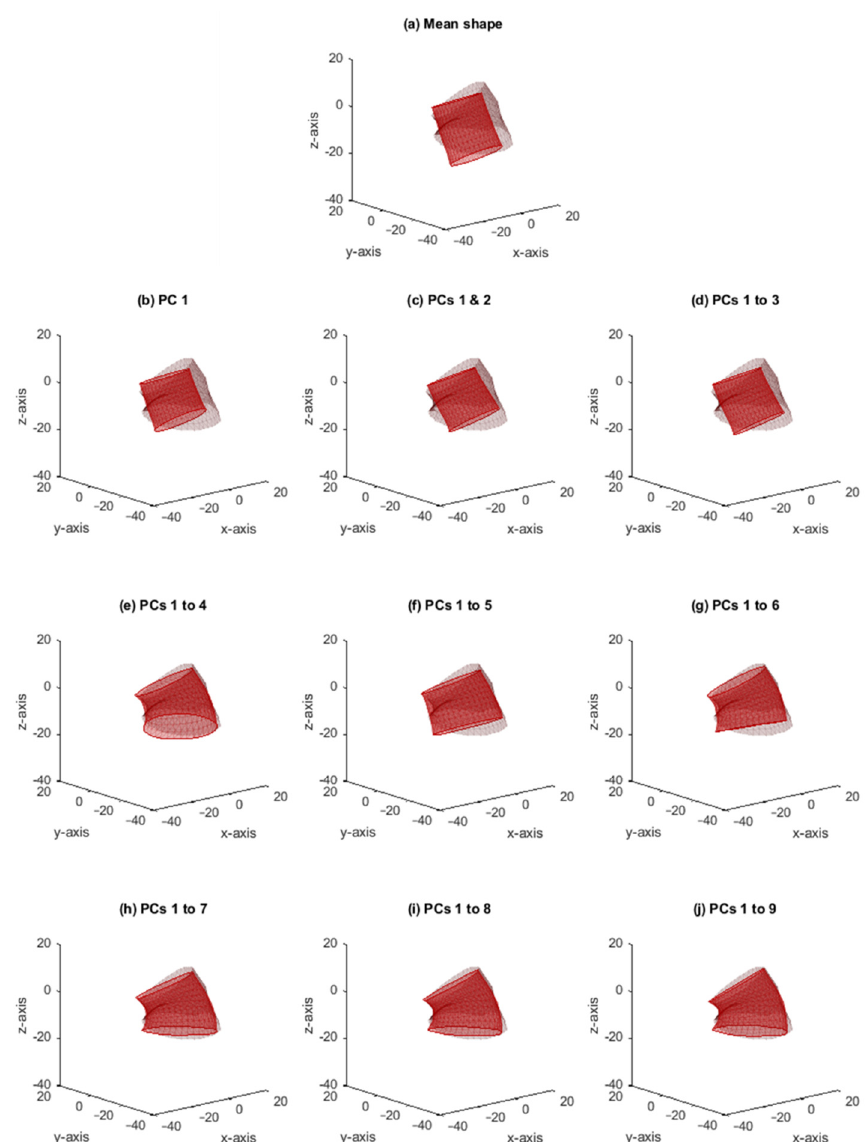
Figure 5. Example of a patient’s original shape (brown mesh) and the reconstructed shape (red mesh), starting with the mean shape as the reconstructed shape ( a ). In each of the subplots ( b – j ), the number of included principal components (PCs) in the statistical shape model (SSM) is increased by one. The root mean square error (RMSE) of principal component (PC) 1 is 6.5 mm, whereas the mean RMSE of PCs 1 to 9 is reduced to 2.5 mm.